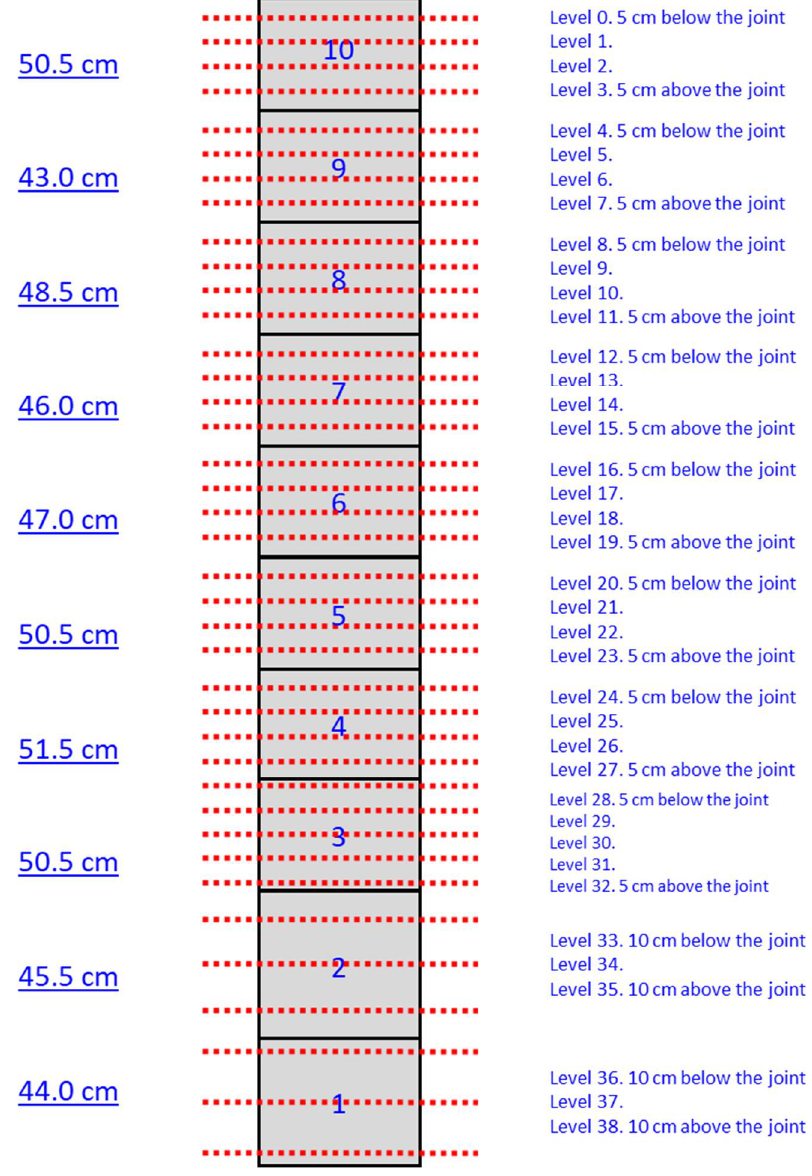
Figure 21. Scheme of the inspections made in shaft of column 3.